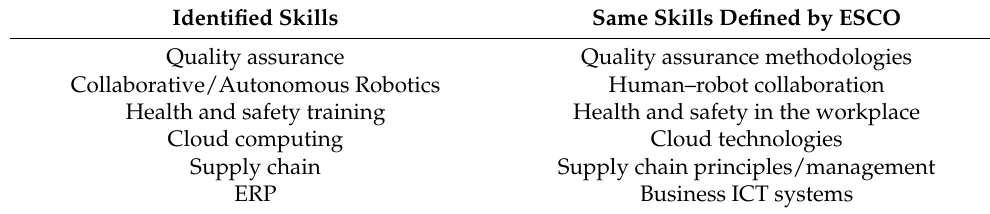
Table 2. Identified skills and their ESCO version.